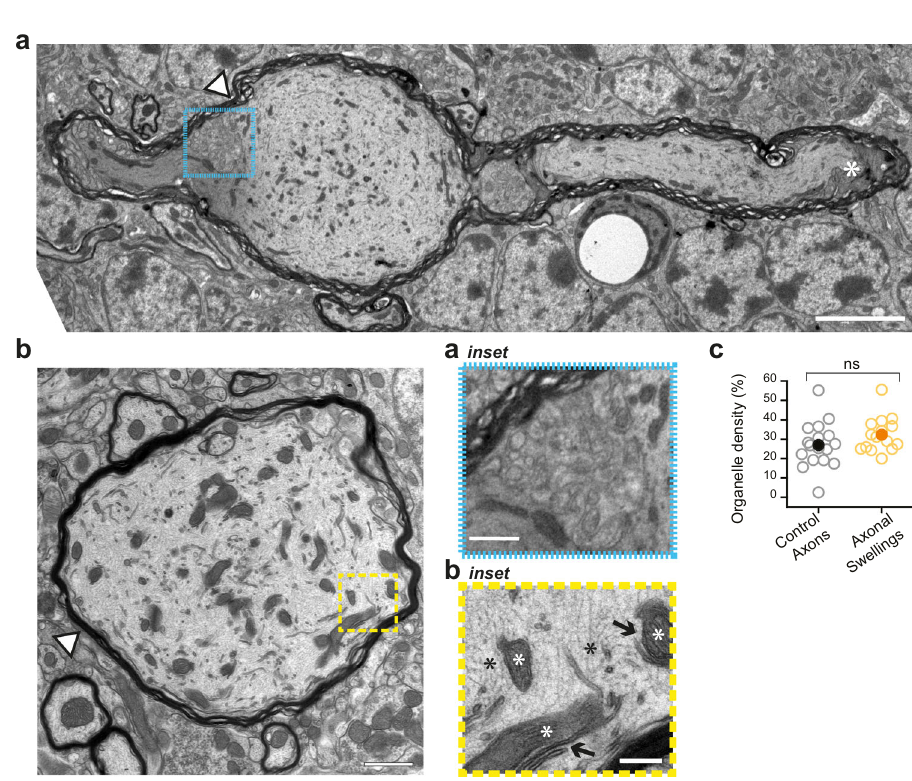
Fig. 3 Purkinje cell axonal swellings are myelinated and are not synaptic structures. a Representative TEM image showing longitudinal cut of axon with swelling and non-swollen sections extending from both sides of swelling (two images of longitudinal axon cut with axonal swellings were acquired). White asterisk shows perinodal protrusions (PNP) indicating proximity of node of Ranvier. Axon dips out of plane of image to the right of the swelling. Scale bar, 5 μ m. Inset below middle: Region of interest delineated by cyan dashed outline in ( a ) shows periaxonal oligodendrocyte cytoplasm. Scale bar, 1 μ m. b Representative TEM image showing crosswise cut of a putative axonal swelling (center) with fi ve neighboring control axons, discernable by presence of dark myelin outline. Fifteen additional images of axonal swellings were acquired during TEM imaging. Scale bar, 1 μ m. Inset right: Region of interest delineated by yellow dashed outline in ( b ) shows mitochondria (white asterisks) that is in close proximity to ER (black arrows), and disorganized neuro fi lament (black asterisks). Scale bar, 500nm. c Axonal swellings are not enriched in organelles compared to control axons. (Organelles were predominantly mitochondria and ER; n = 17 control axons; n = 15 putative axonal swellings, two-tailed Student ’ s t- test, P = 0.162). Data were presented as mean±SEM (ns P >0.05). Source data are provided as a Source Data fi